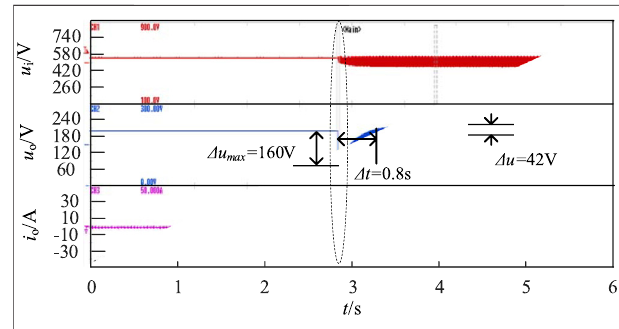
FIGURE 10 | Experimental waveforms of the system under the load mutation.